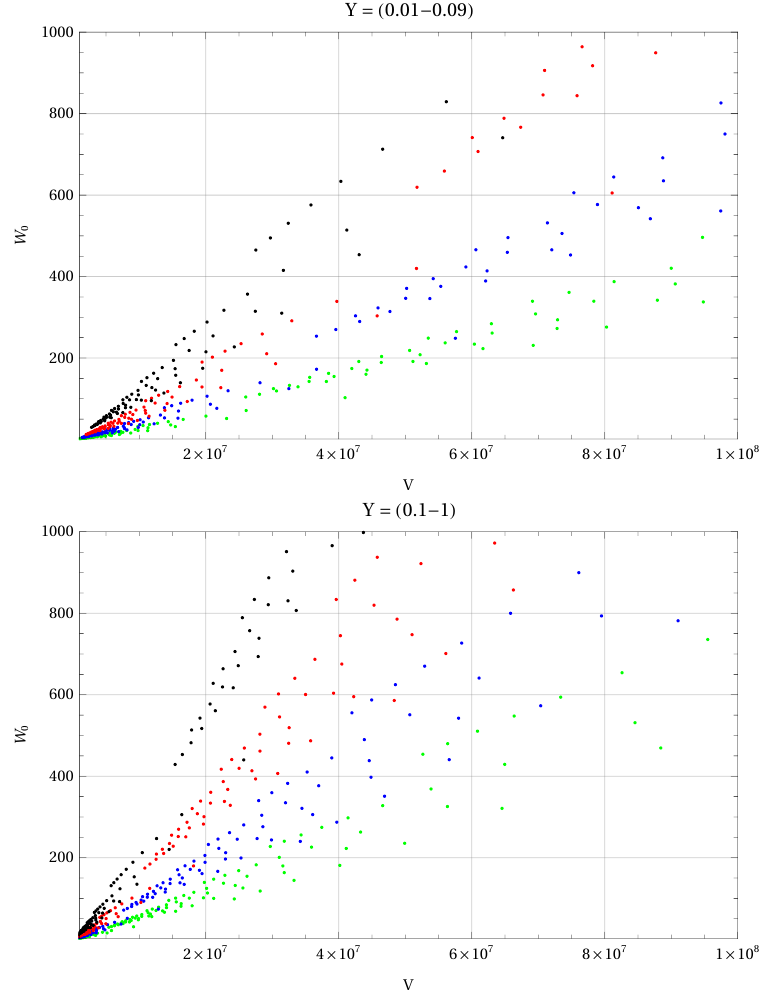
Figure 3 . Selected data points for different values of Y φ and λ . Around 42% of the data points are in the lower Y regime, while around 58% are in the upper regime. Black points correspond to φ λ = 10 4 , red to λ = 10 3 , blue to λ = 10 2 , and green to λ = 10